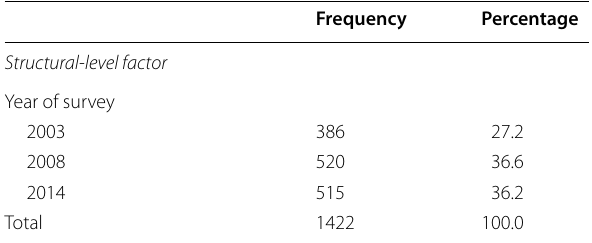
Table 2 Prevalence of multiple sexual partnerships by selected characteristics of adolescent boys and young men between